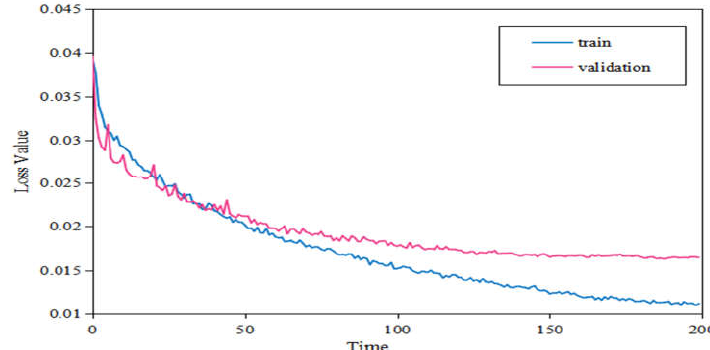
Figure 4. Effect of training on loss value obtained for the test dataset.